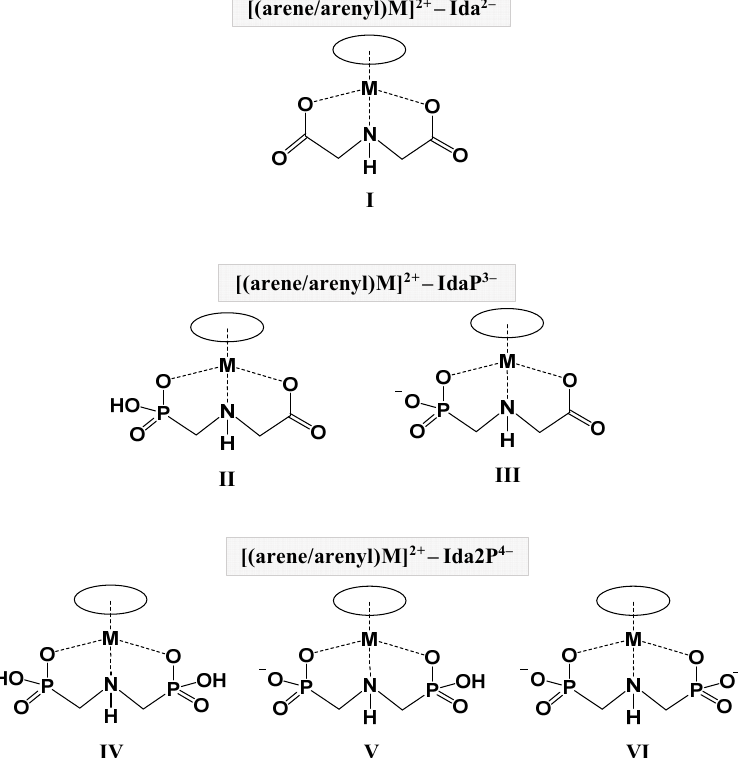
Figure 2. Suggested solution structures of the complexes formed in the [(arene/arenyl)M] 2+ – Ida 2 − , IdaP 3 − and Ida2P 4 − systems ([(arene)M] 2+ = [( η 6 - p -cym)Ru] 2+ , [( η 6 - p -cym)Os] 2+ ; [(arenyl)M] 2+ = [( η 5 -Cp*)Rh] 2+ , [( η 5 -Cp*)Ir] 2+ ).